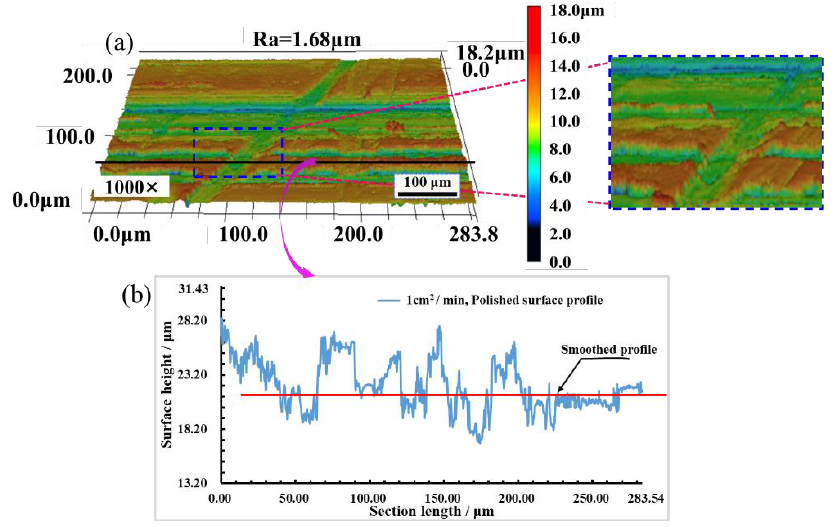
Figure 17. Surface morphology and profile with SPS N of 1 cm 2 /min. ( a ) Surface morphology; ( b ) Surface profile.